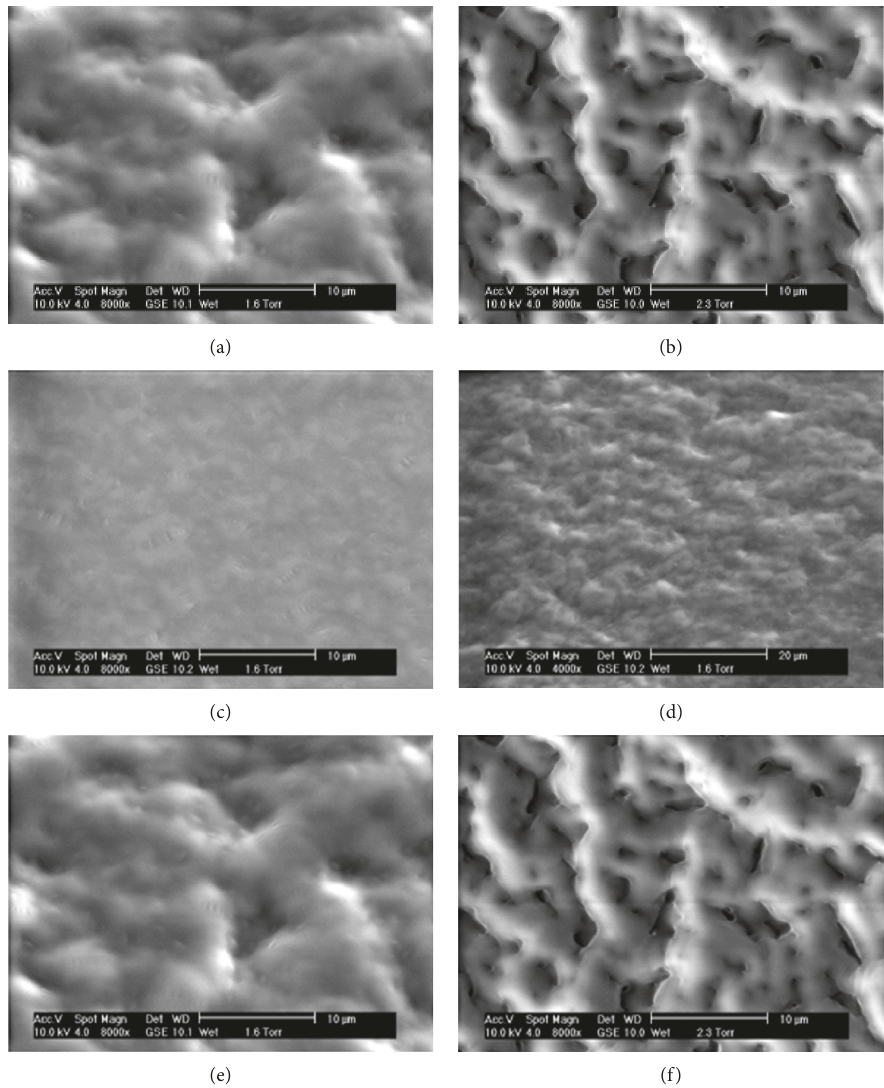
Figure 18: (a) ESEM profile of asphalt after aging at 0 ° C for 2minutes, (b) after aging at 5 ° C for 2 minutes, (c) 10 ° C for 2 minutes, (d) 15 ° C for 2 minutes, (e) 20 ° C for 2 minutes, and (f) 25 ° C for 2 minutes. The figure is obtained from Gaskin [44] (under the creative commons attribution license/public